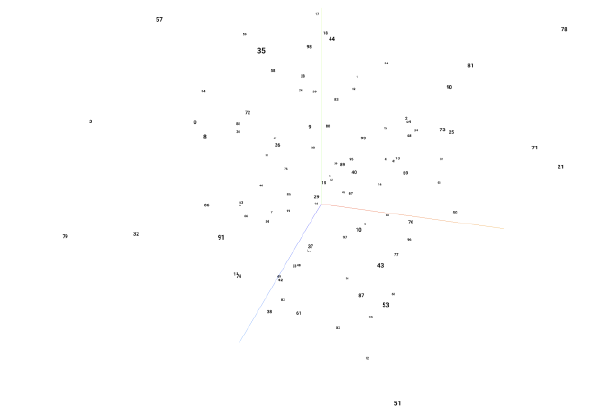
Figure 6. The demonstration of the PCA 4-5-6 result.